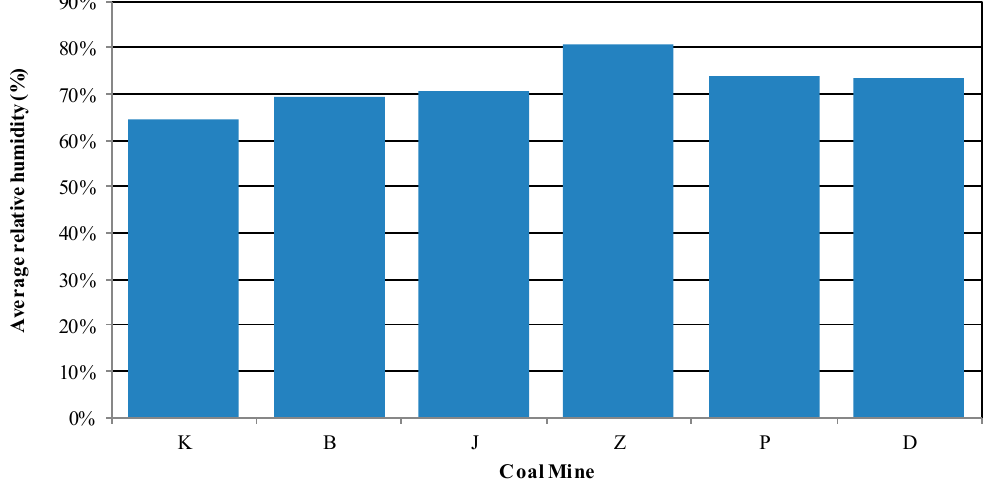
Coal Mine Coal Mine Figure 11. Average relative humidity in particular mines. Figure 11. Average relative humidity in particular mines. Figure 11. Average relative humidity in particular mines.